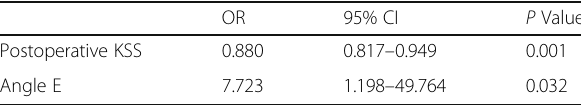
Table 5 Multivariate Logistic regression results of patient satisfaction OR 95% CI Postoperative